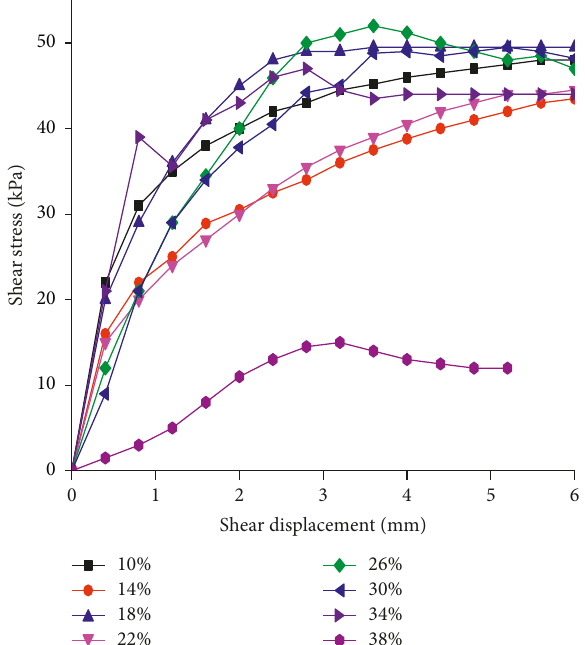
Figure 4: Shear stress-shear displacement curves of the microbial cementation solution-modified loess samples with different ratios under vertical pressure of 100mkPa.